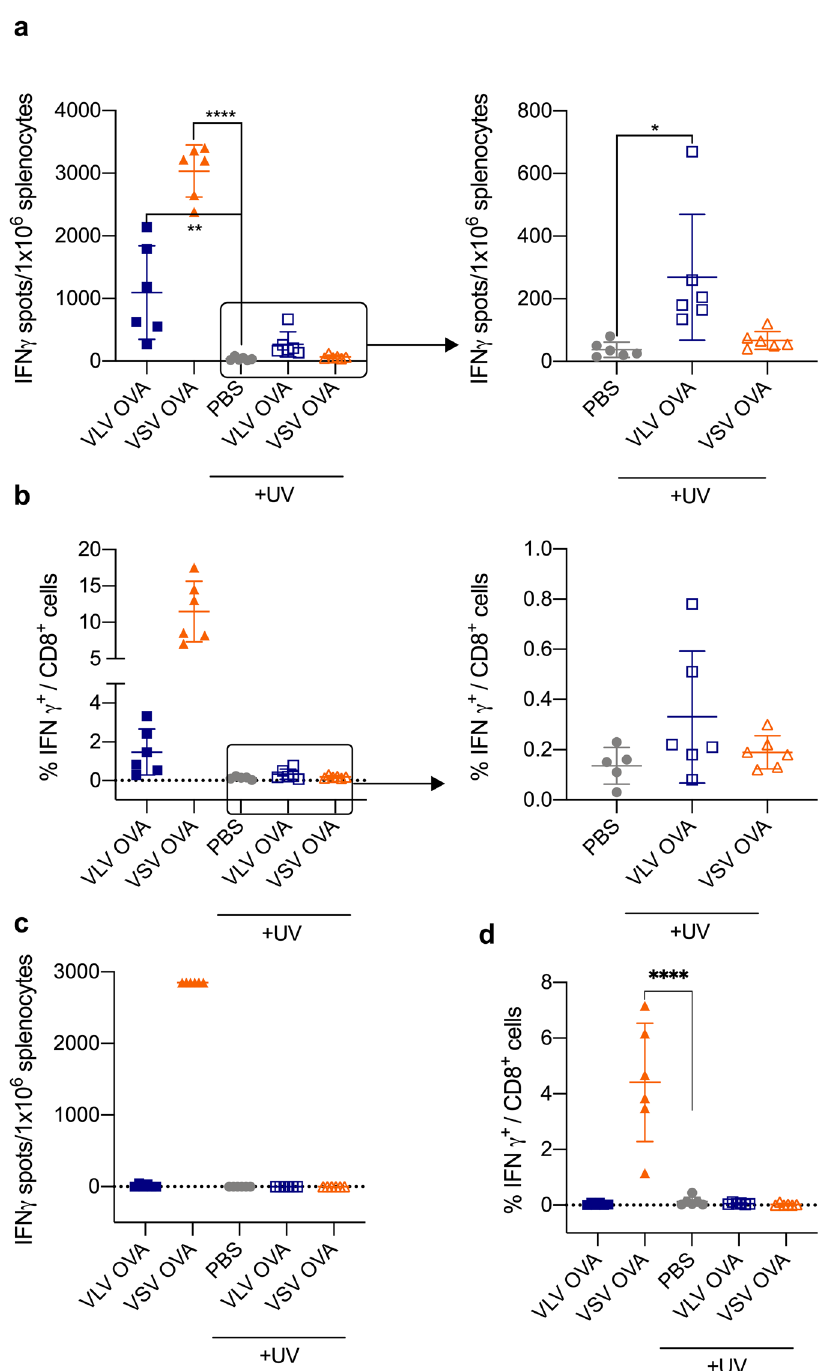
Fig. 7 UV-inactivated VLV primes antigen-speci fi c CD8 + T cells. Mice received spleen cells from OT-I mice and were subsequently immunized with VLV, UV-inactivated VLV, VSV, UV-inactivated VSV, or PBS. One week after immunization, spleen cells from immunized mice were analyzed by fl ow cytometry and ELISPOT for the presence of SIINFEKL-speci fi c CD8 + T cell responses. a ELISPOT quanti fi cation of SIINFEKL-speci fi c IFN- γ - producing cells. b Percentage of IFN- γ -producing CD8 + T cells after stimulation with SIINFEKL determined by intracellular cytokine